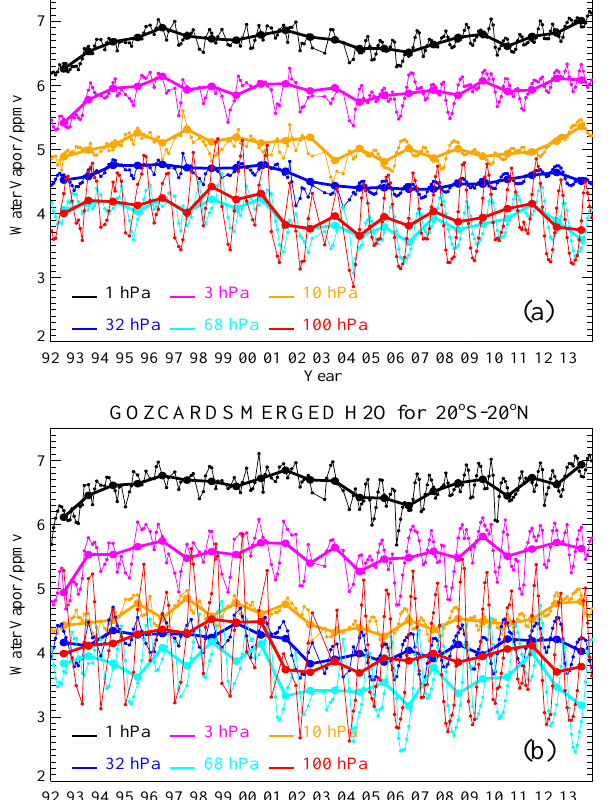
Figure 14. Variations in stratospheric water vapor from the GOZ- CARDS H 2 O merged data records (1992 through 2013) averaged from (a) 60 ◦ S to 60 ◦ N and (b) 20 ◦ S to 20 ◦ N. Monthly average values and annual averages are shown by thin and thick lines (con- necting similarly colored dots), respectively, for the pressure levels indicated in the plot legend.